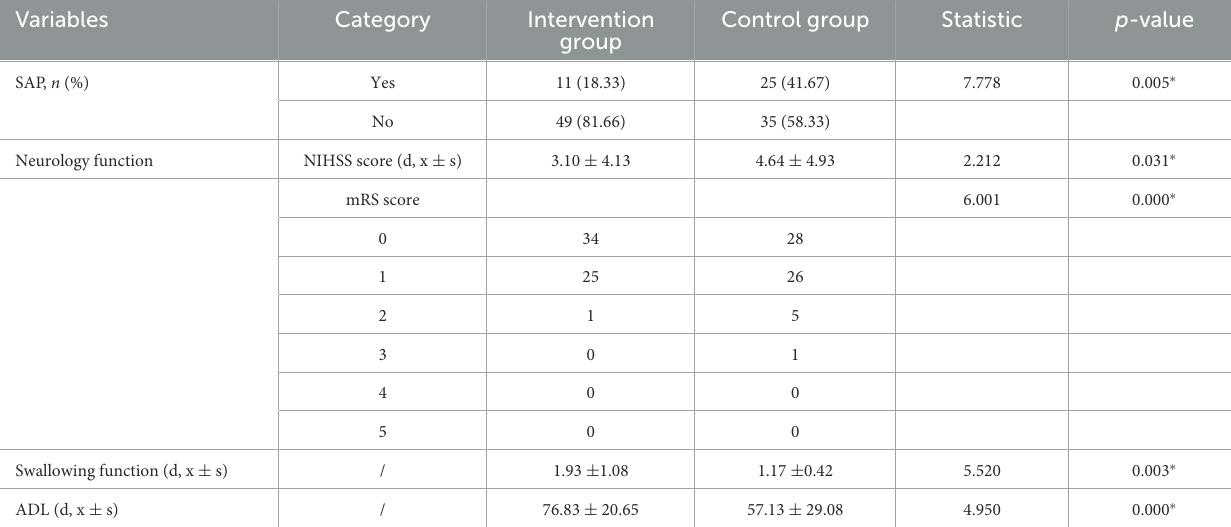
TABLE 3 The comparisons in outcomes between two groups after intervention. Variables